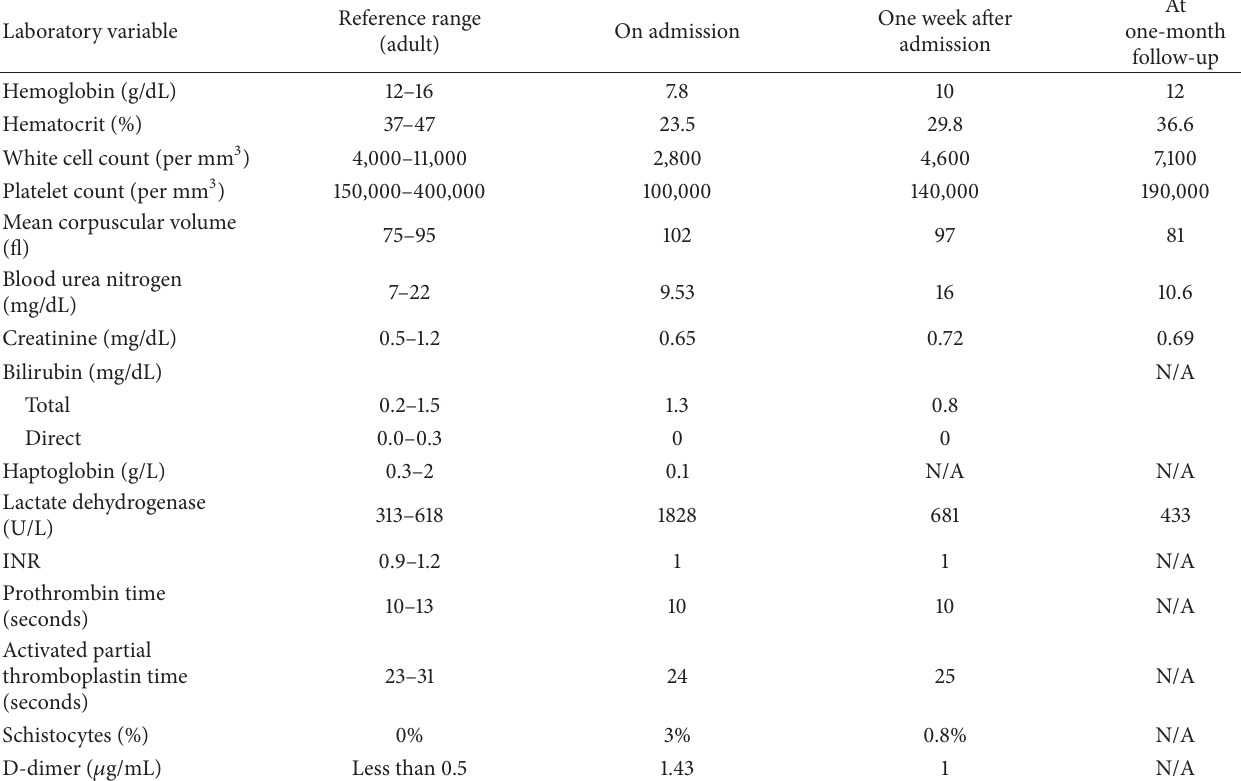
Table 1: Laboratory values on admission, one week and at one-month follow-up after